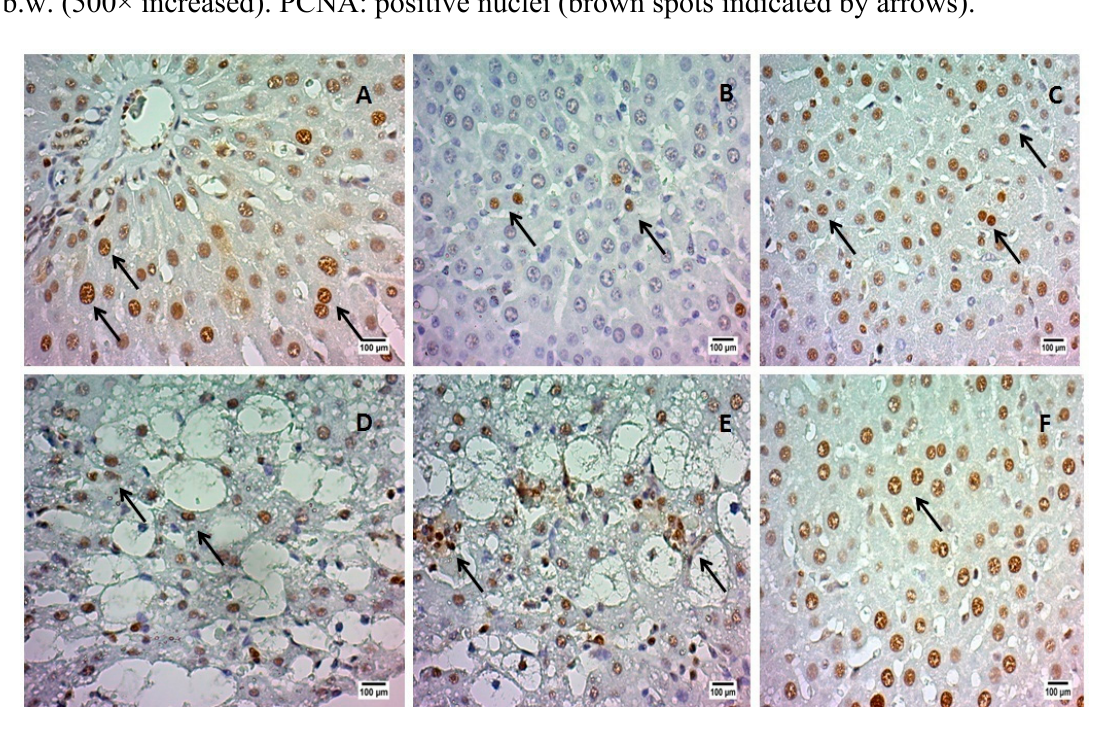
Figure 2. PCNA immunohistochemical analyzes of rats’ livers treated with aqueous extract of Simarouba amara stem bark (SAAE). ( A ) Vehicle (corn oil); ( B ) Control (CCl 4 ); ( C ) Legalon ® ; ( D ) SAAE 100 mg/kg b.w.; ( E ) SAAE 250 mg/kg b.w.; ( F ) SAAE 500 mg/kg b.w. (500× increased). PCNA: positive nuclei (brown spots indicated by